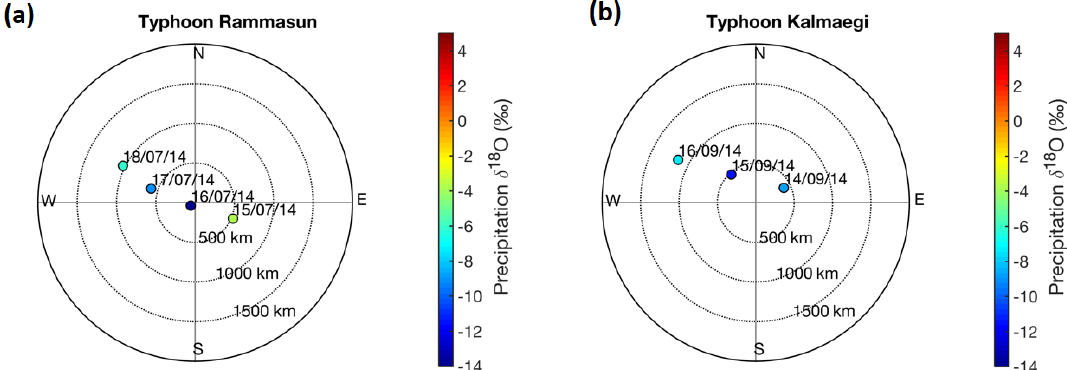
Figure 8. Spatiotemporal evolution of δ 18 O isotopes. Centred on the Metropolitan Manila collection site, different radii provide information on distance between the storm’s centre to Metropolitan Manila. δ 18 O values are colour-coded. (a) Rammasun. (b) Kalmaegi. Please note that the date format in this figure is